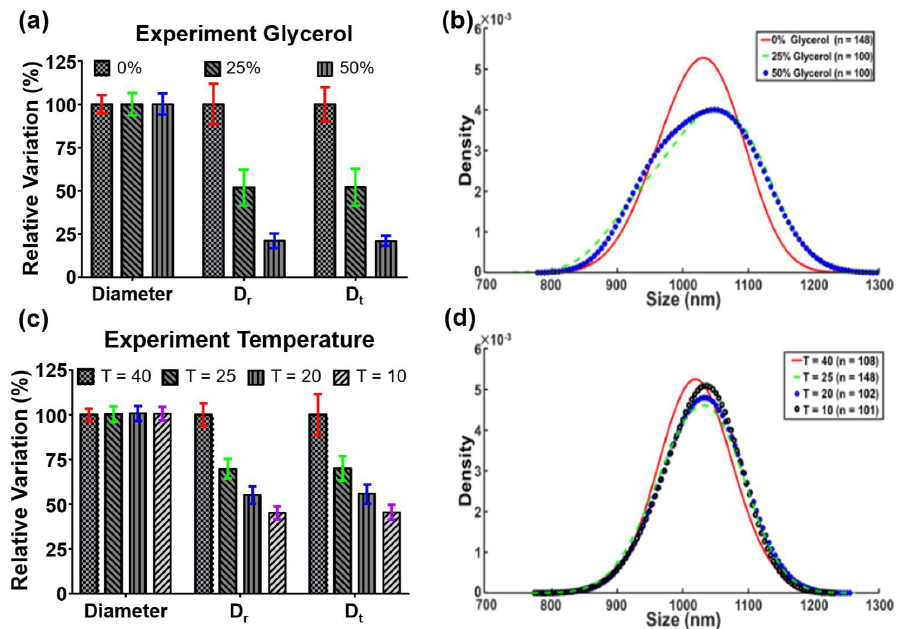
40 ◦ C. ( j ) The trajectory of the particles under different conditions. The red, blue, and black lines denote the particles under pure water at 25 ◦ C, 50% glycerol solution at 25 ◦ C, and pure water at 40 ◦ C, respectively.